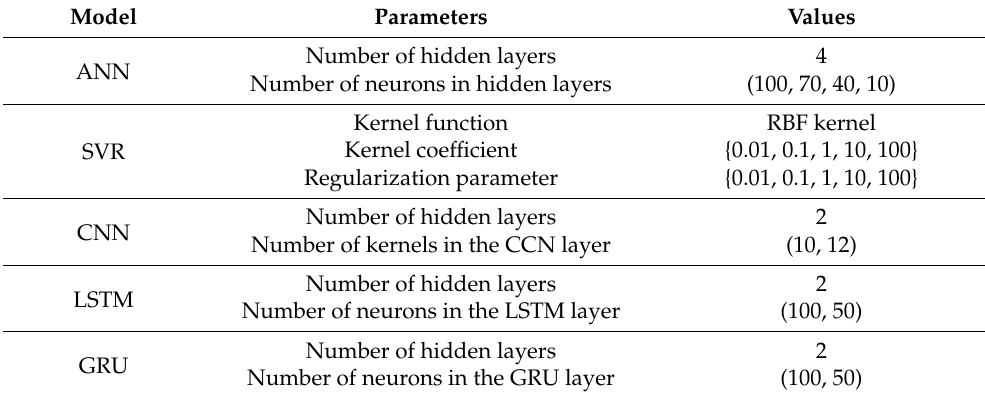
Table 4. Configuration of models used in this